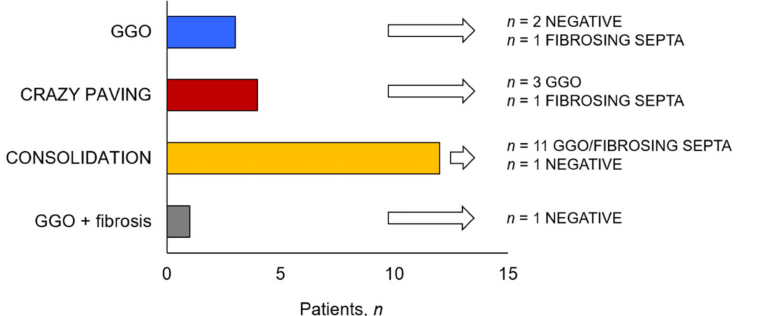
Figure 3. Changes in radiological patterns after 6 weeks from hospital discharge. GGO = ground glass opacities.